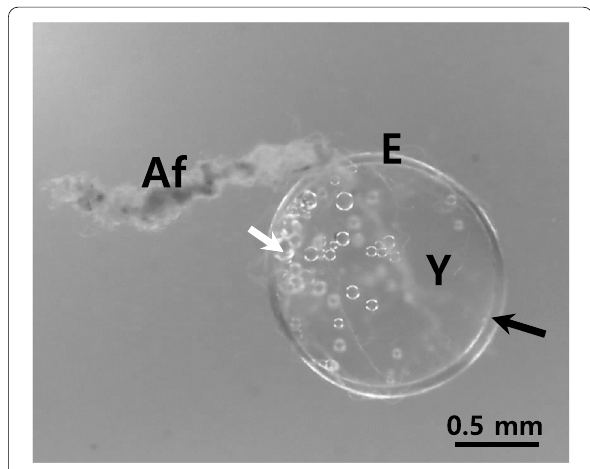
Fig. 1 A fertilized egg of lampeye, Poropanchax normani . White arrow, lipid droplets; E, egg envelope; Y, yolk. The perivitelline space (black arrow) was very small and a bundle of adhesive filaments (Af) was on one side of the fertilized egg